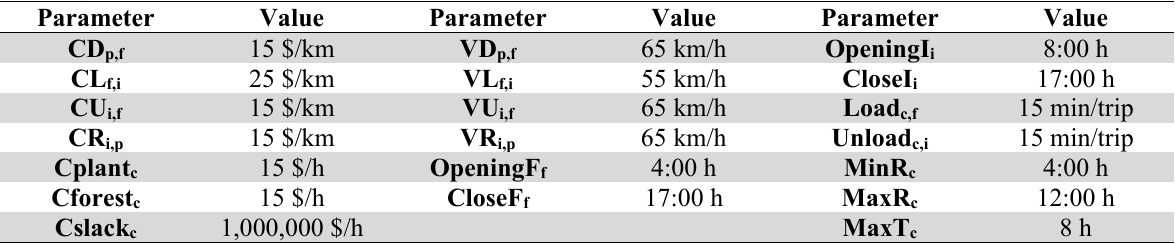
Model parameters for Case I Parameter